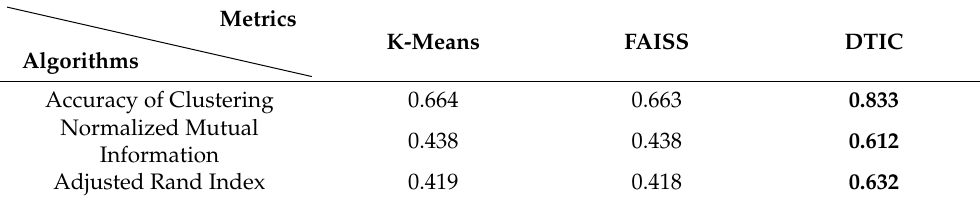
Table 4. A comparison of different methods on the Reunion Island Dataset with averaged initial cluster centers. The bolded results show the best results. Metrics K-Means FAISS DTIC Algorithms Accuracy of Clustering 0.664 0.663 0.833 Normalized Mutual 0.438 0.438 0.612 Information Adjusted Rand Index 0.419 0.418